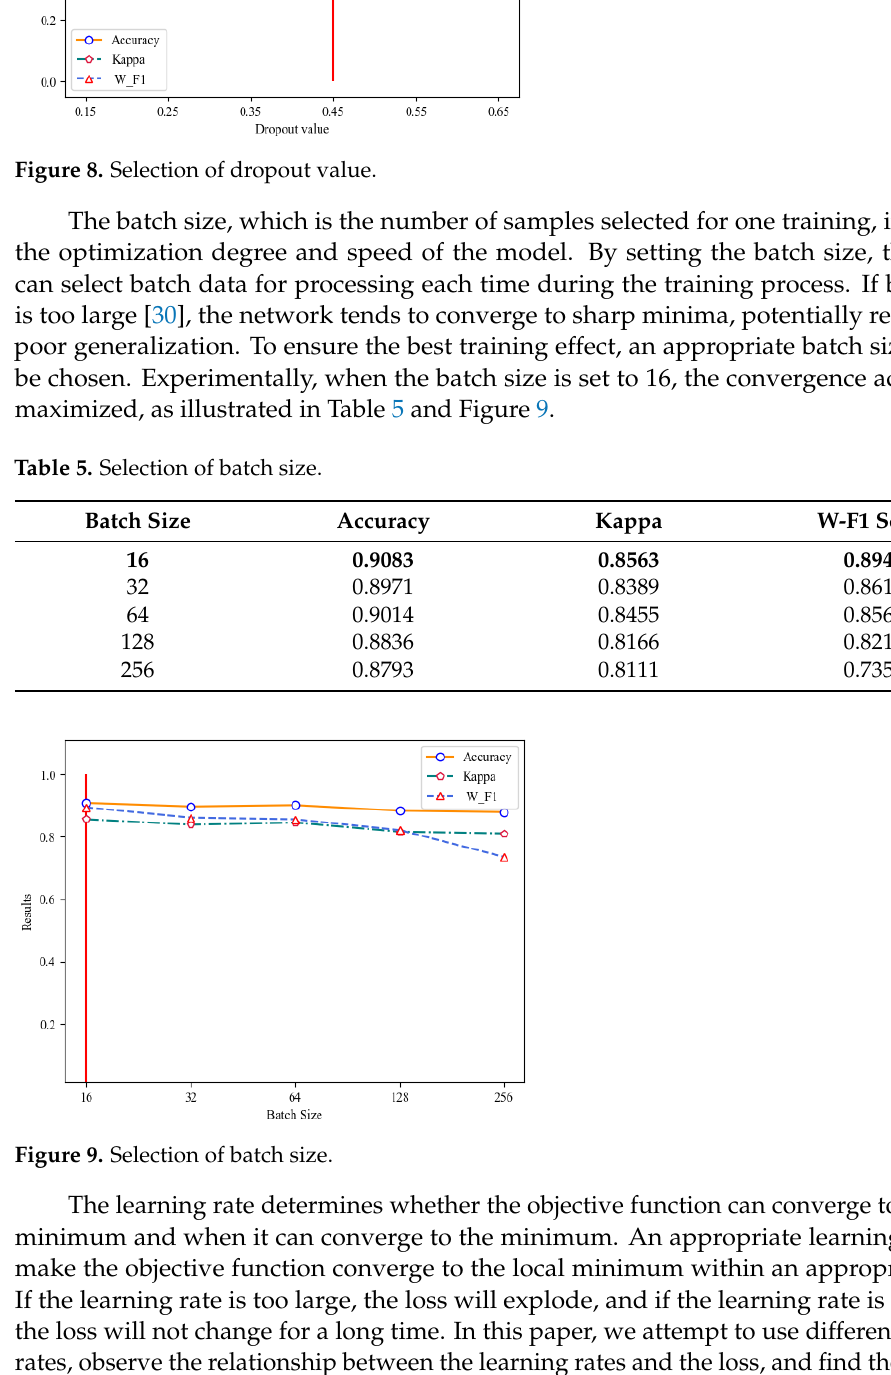
Figure 10. Selection of learning rate . Table 6. Selection of learning rate. Learning rate